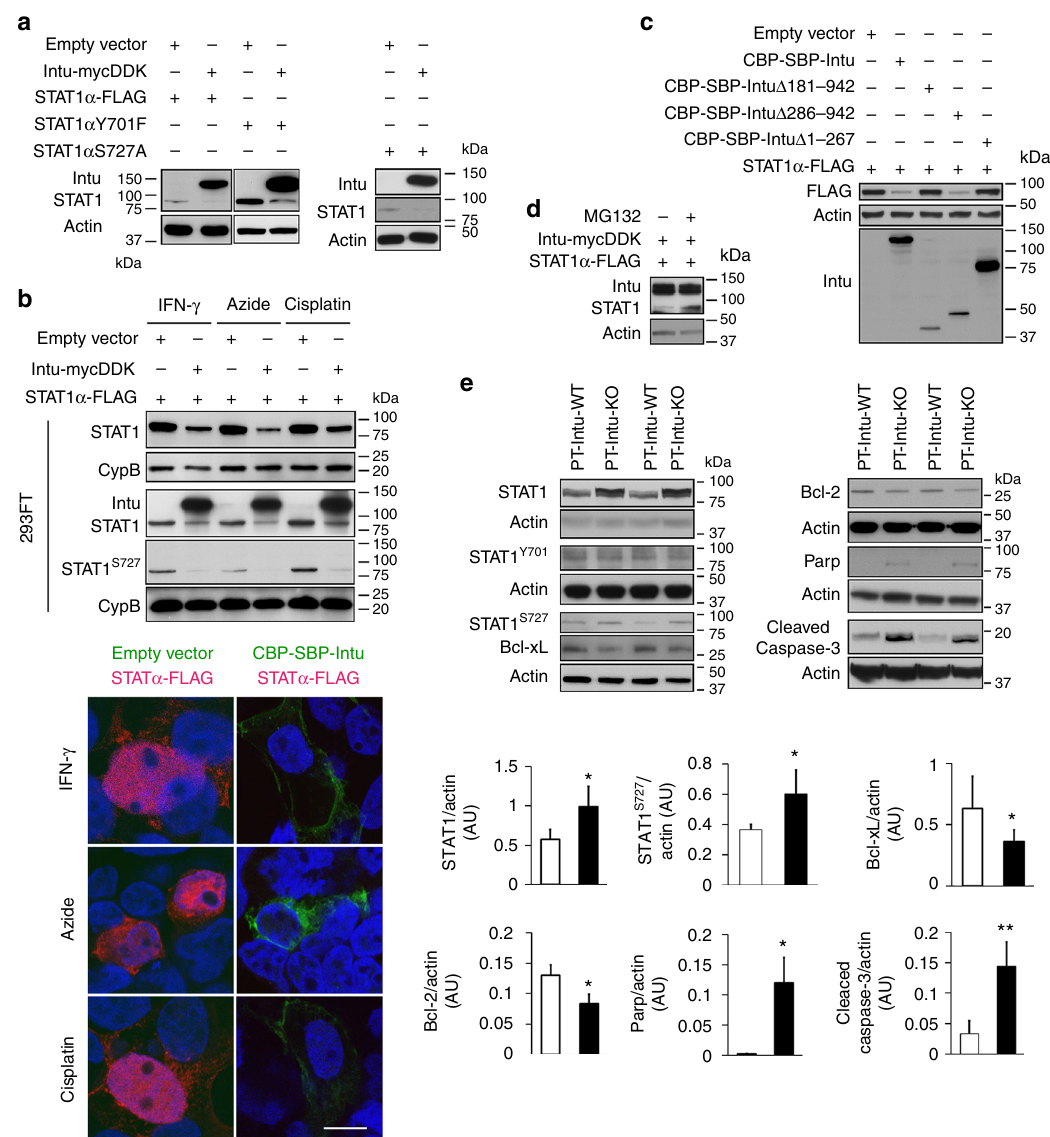
Fig. 5 Intu targets STAT1 for degradation. a Co-transfection of Intu-mycDDK reduced the expression of FLAG-tagged STAT1 α and its phosphorylation mutants (STAT1 α Y701F, STAT1 α S727A) in 293FT cells. b Intu suppressed the expression of total and phosphorylated STAT1 during IFN- γ , azide, or cisplatin treatment of 293FT cells. c Intu or its deletion mutants were co-transfected with STAT1-FLAG into 293FT cells, showing the suppressive effect of full-length Intu and Intu Δ 268-942 on STAT1 expression. d MG132 improved STAT1 expression in Intu-transfected cells. e Higher levels of total and phosphorylated STAT1, cleaved Caspase-3, and Parp, and lower levels of Bcl-2 and Bcl-xL were observed in PT-Intu-KO kidney tissues, in comparison to the wild type. Quanti fi cation was done by densitometry of immunoblots ( n = 3 – 4). Quantitative data are mean ± s.d. (error bars). Paired t test was used. * p < 0.05, ** p < 0.01. Scale bar: 10 µ